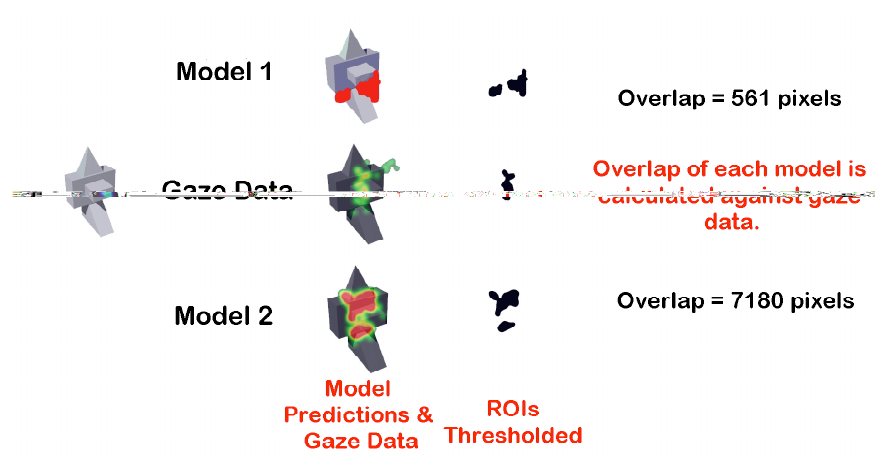
Figure 4 – An example stimulus along with the thresholded-recorded data (‘Gaze Data’ - middle) and the predicted fixation patterns from the saliency model (‘Model 1’ - top) and the 3-D intersection model (‘Model 2’ - bottom). Also shown are the binarised and extracted ROIs along with the overlap of each model’s ROIs with the recorded data